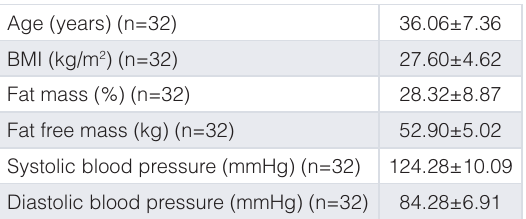
Table 1. Characteristics of the